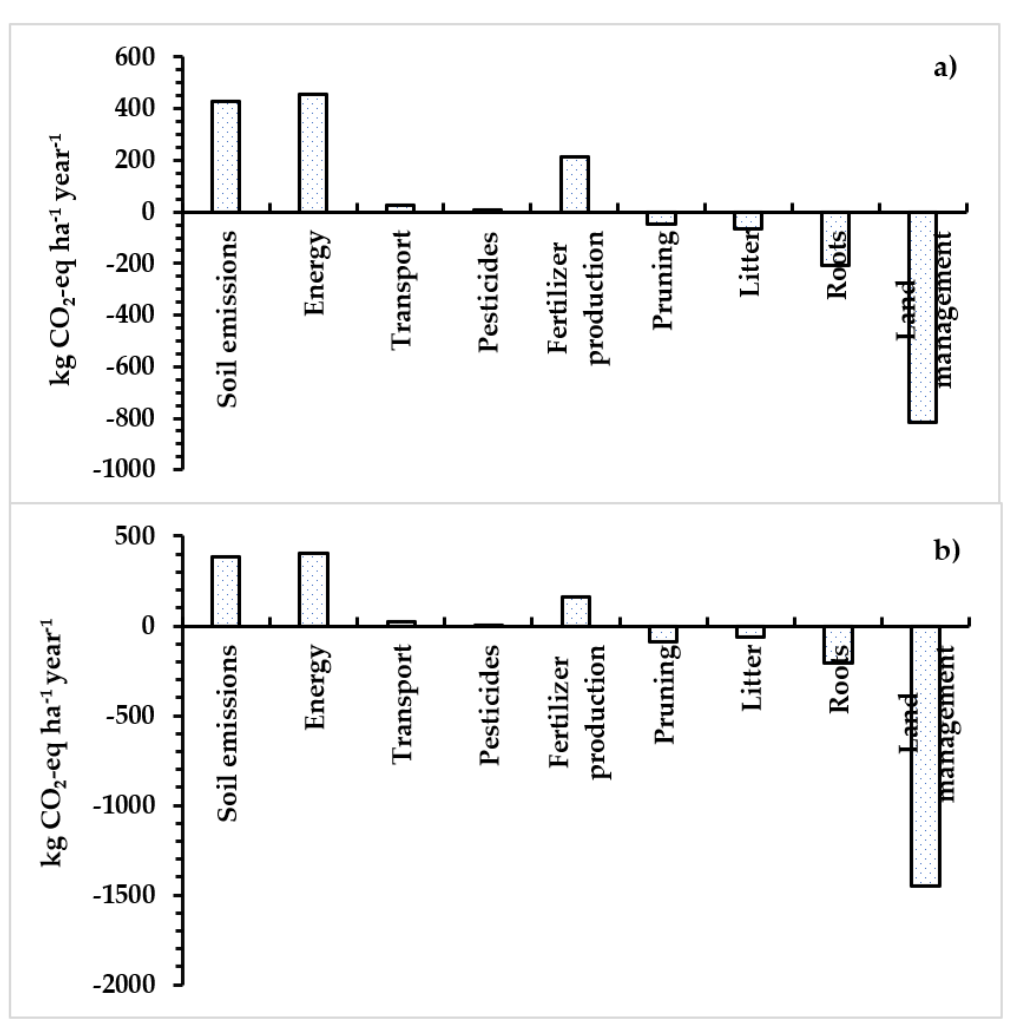
Figure 5. Contribution of parameters and management practices to the CF; data in kg CO 2 -eq ha −1 year −1 for ( a ) the zero-emissions grape production scenario and ( b ) for the carbon farming scenario.